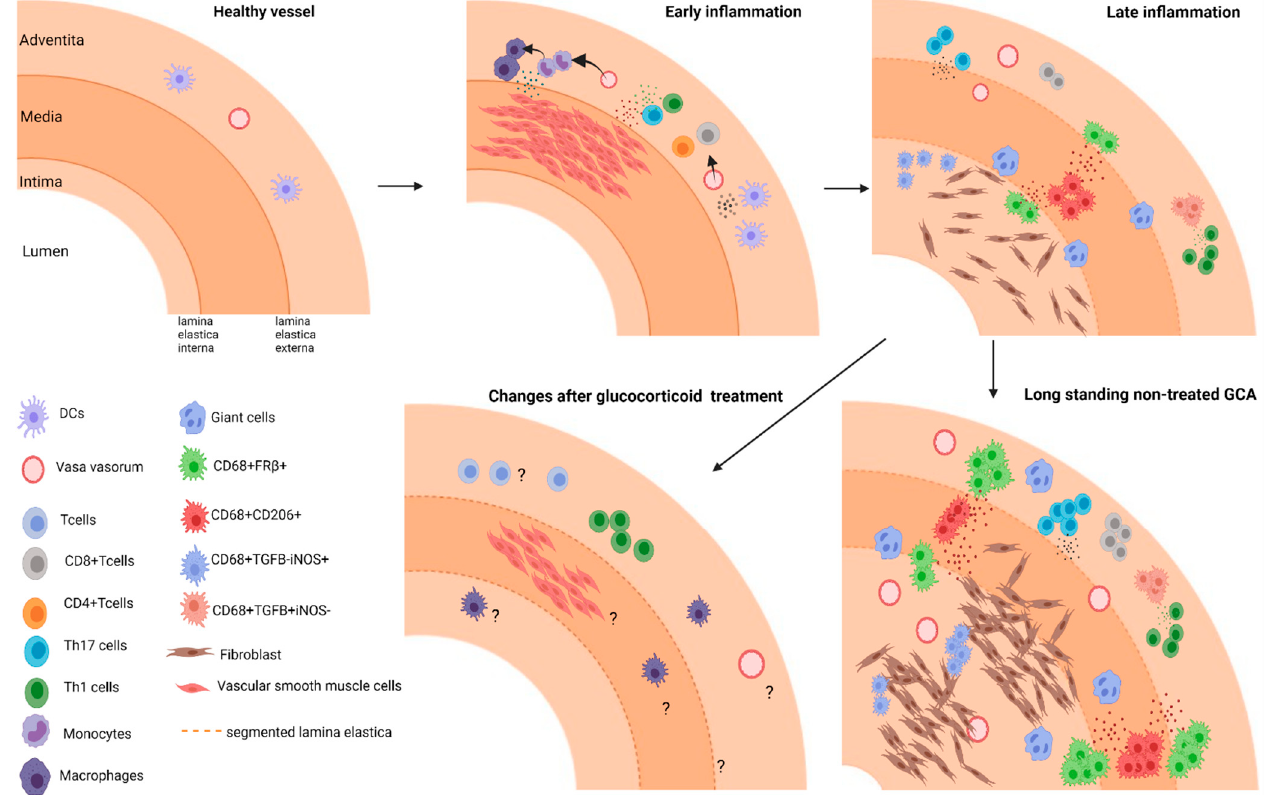
Figure 1. Model of different stages in arterial inflammation in GCA. Early inflammation: Dendritic cell activation recruits T cells (CD4+ and CD8+) to the vessel wall and drives activation, and polarization of T cells. Secreted soluble factors lead to monocyte recruitment and their differentiation into macrophages. Late inflammation: Different macrophages subsets skewed by environmental cues contribute to tissue remodeling in GCA. CD206+ GM-CSF skewed macrophages producing MMPs mediate tissue destruction; FR β +M-CSF skewed macrophages and fibroblast are activated and drive intimal proliferation. Long standing GCA: ultimately inflammation leads to vascular occlusion. Changes after glucocorticoid treatment: The effect of treatment on cellular infiltrates and vascular lesions/repair remain to be elucidated.